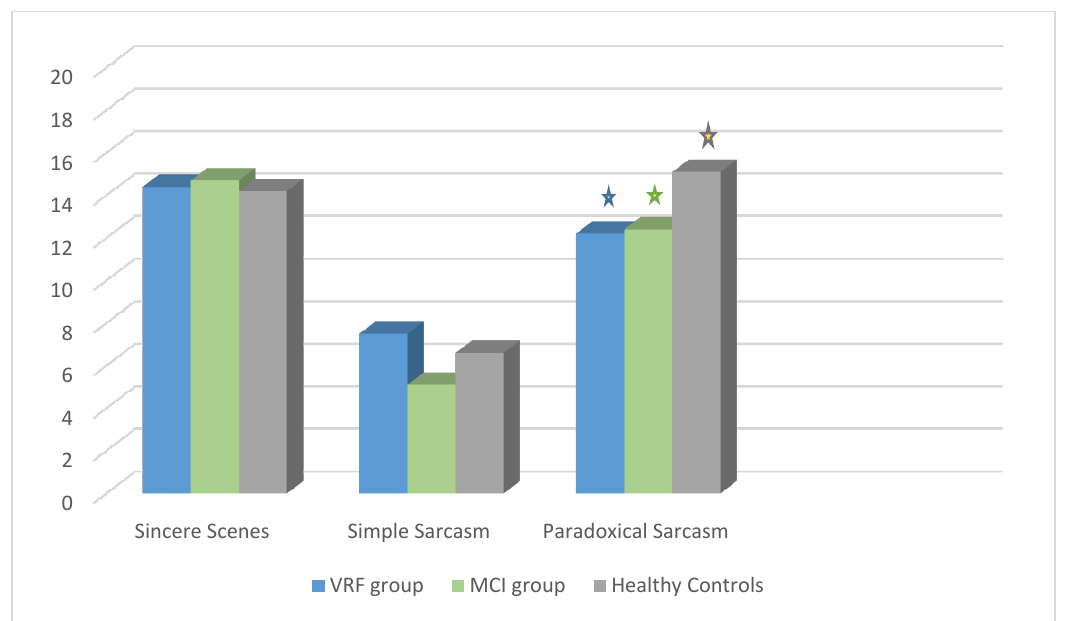
Figure 1. TASIT—Sincere, Simple Sarcasm, and Paradoxical Sarcasm: Mean of adults with vascular risk factors, patients diagnosed with mild cognitive impairment and healthy controls. * Statistical significant results.